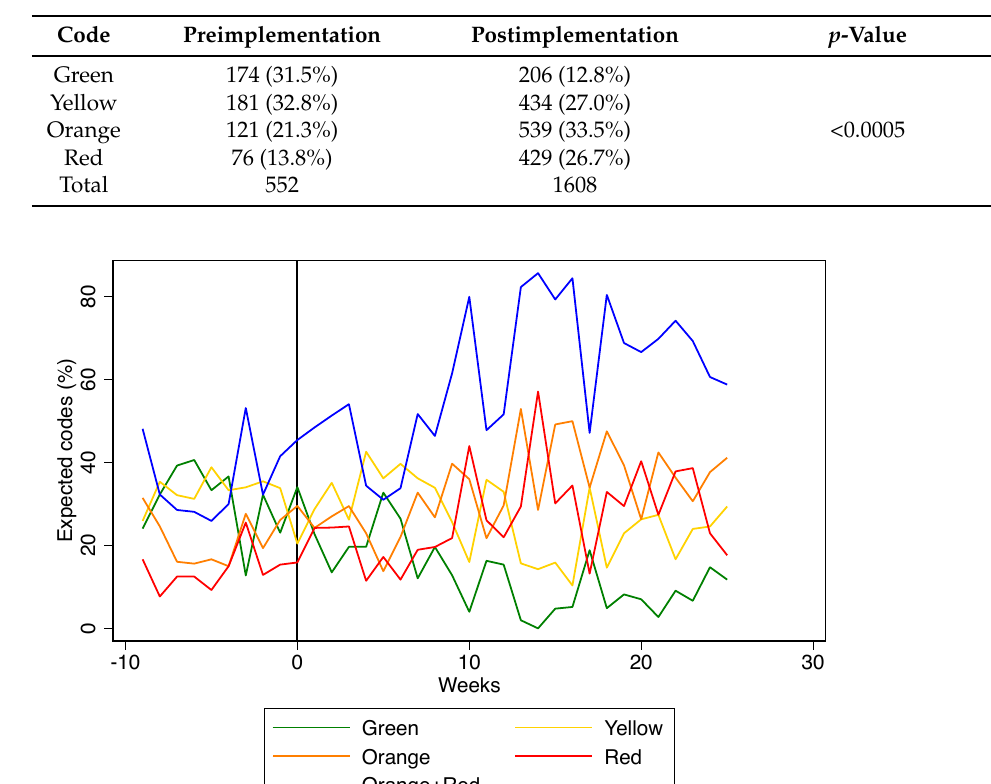
Table 2. Expected codes of referred patients before and after SATS implementation.